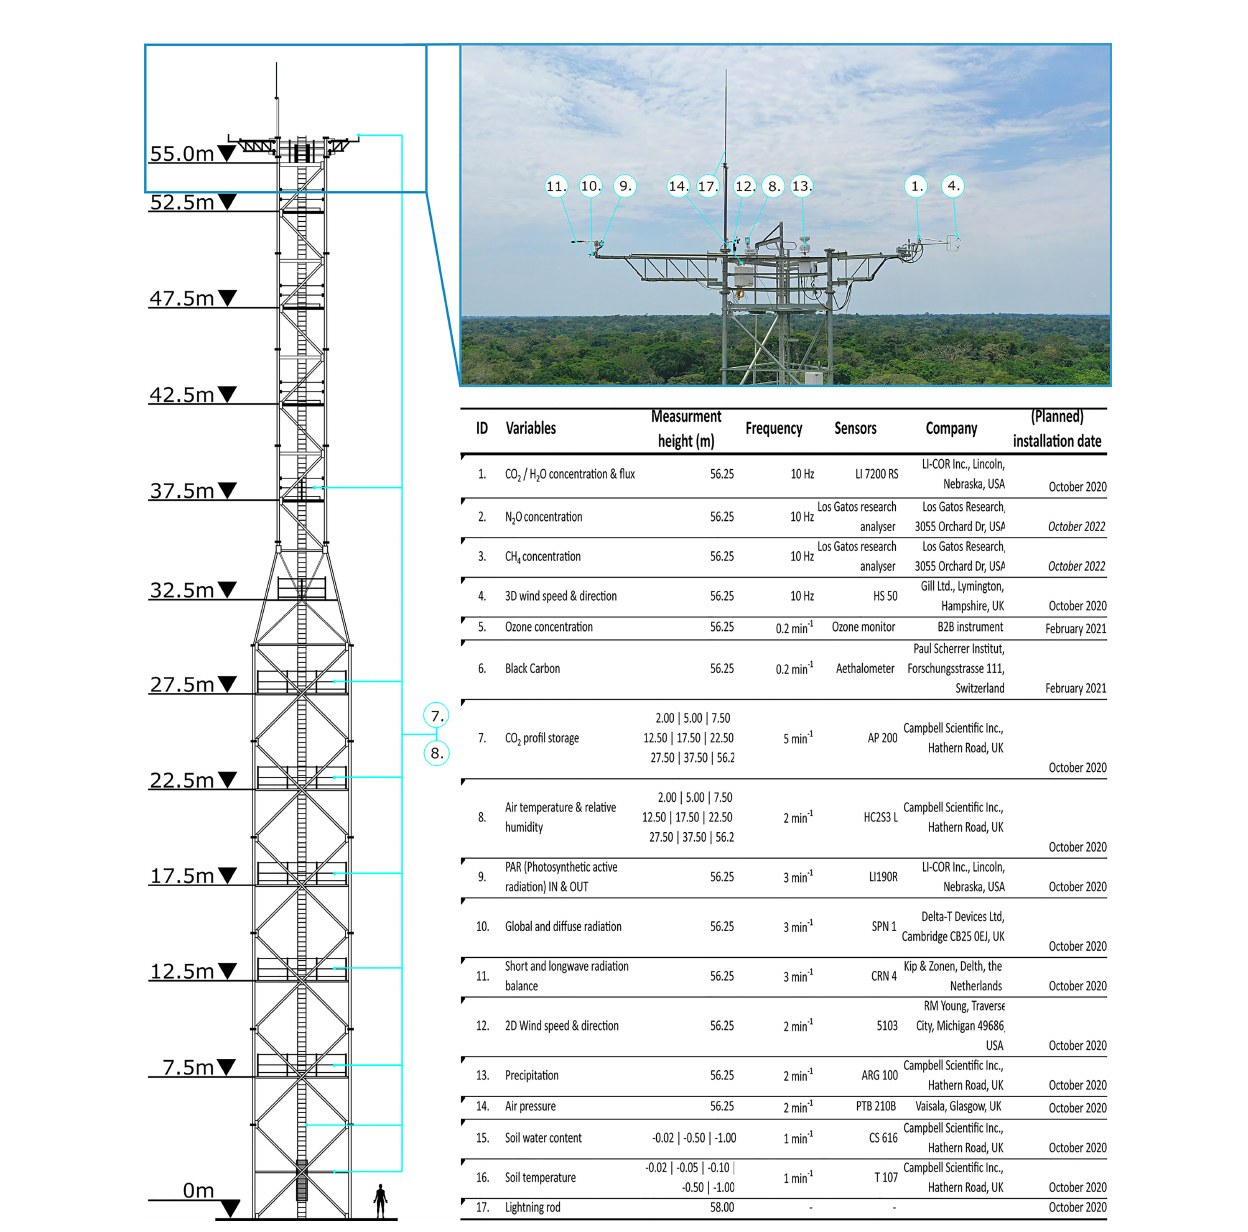
FIGURE 3 | The CongoFlux eddy covariance fl ux tower structure and its equipment, Yangambi (DR Congo) [Top-right picture was taken on October